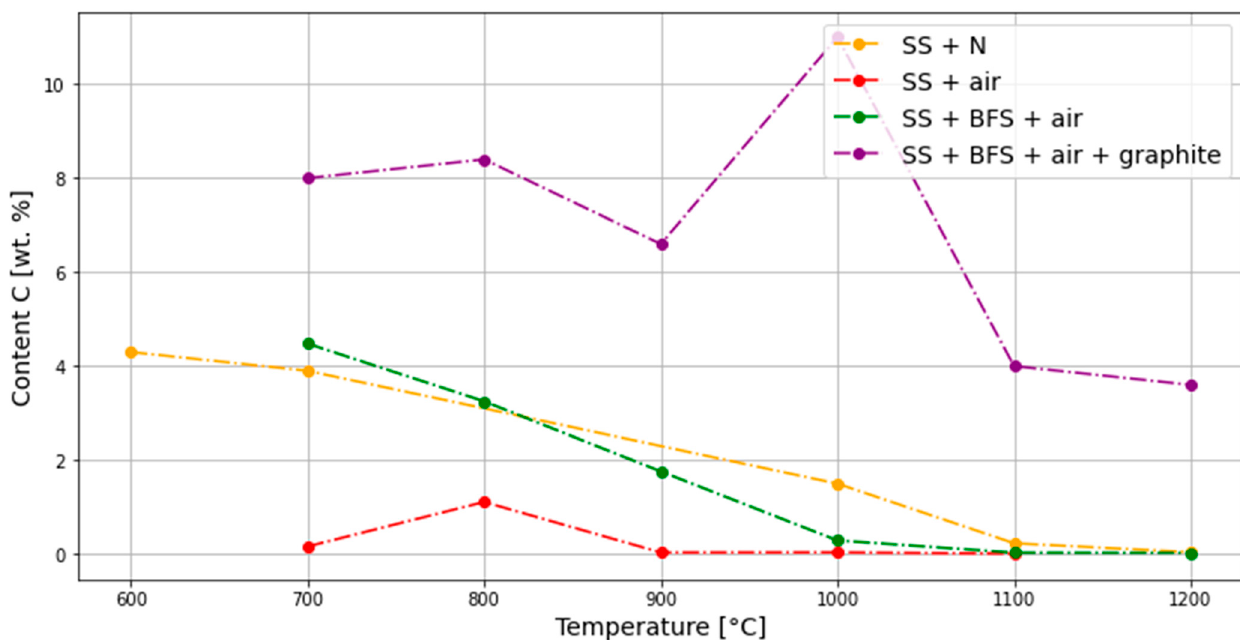
Figure 6. Effect of temperature, atmosphere and reducing element on C content in sludge.